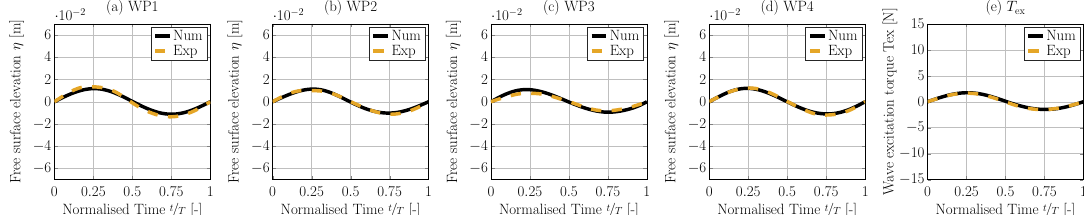
Figure 9. Phase-averaged free surface elevation, measured at wave probes WP1–WP4 ( a – d ), and wave excitation torque ( e ) for wave RW1.